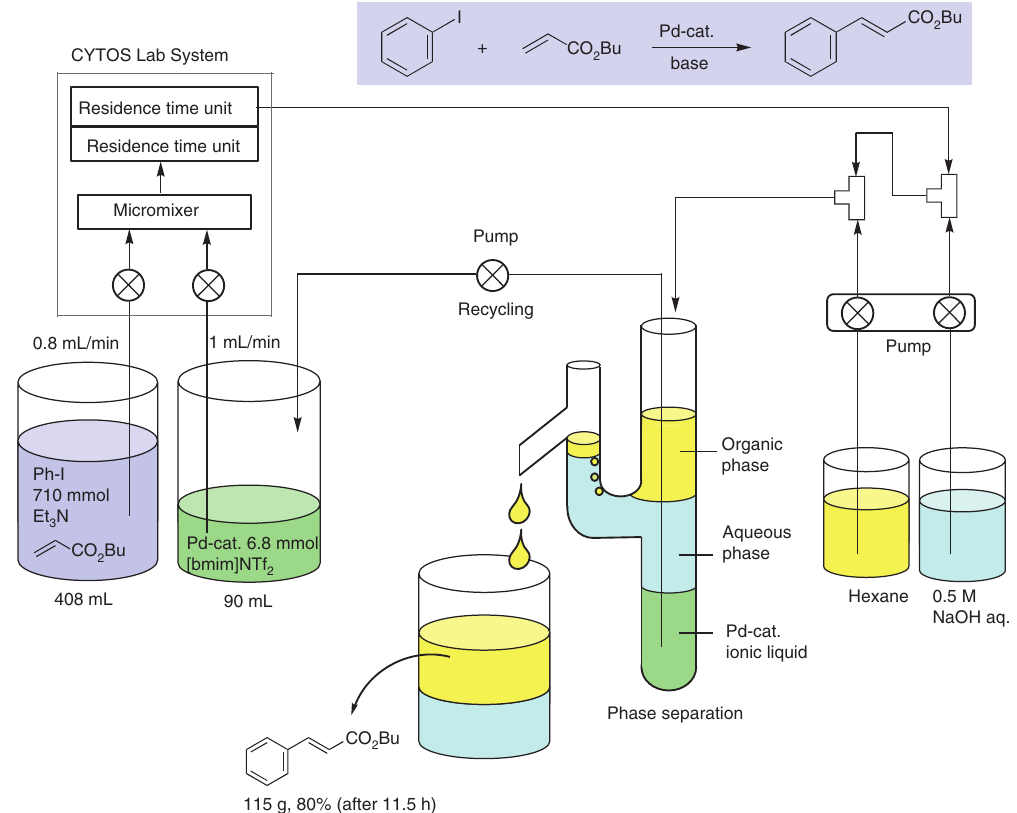
Scheme 9 Production of butyl cinnamate using circulatory catalyst flow